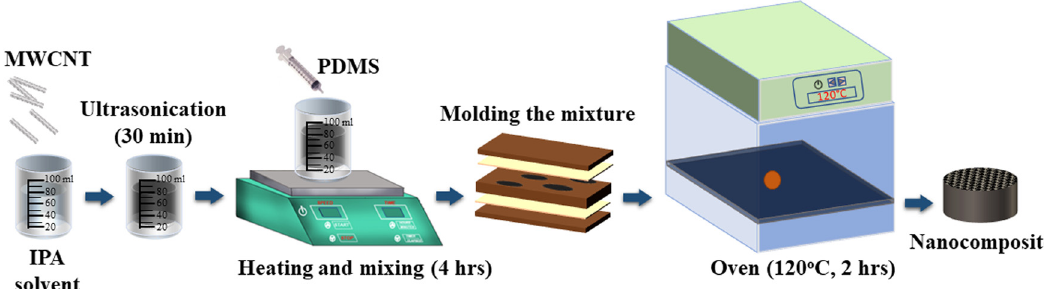
Figure 2: Schematic of the preparation process of PDMS/MWCNT nanocomposites.